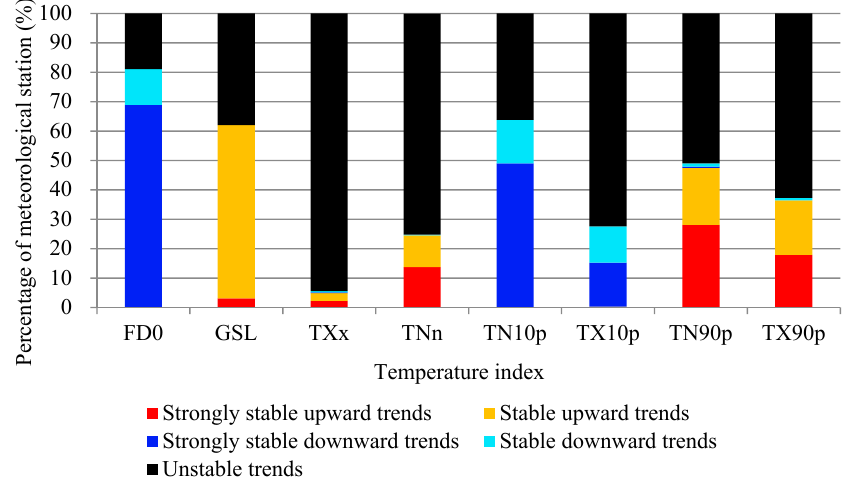
Figure 7. Percentage of stations with stable trends in extreme temperature indices during the growth period of October 1961 to May 2016.